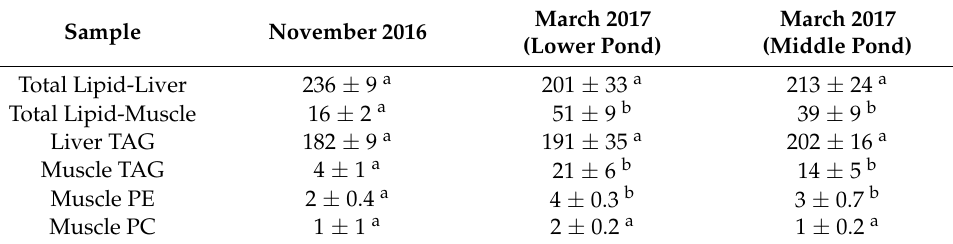
Table 2. Mean ( ± SD) total lipid and liver triacylglycerols (TAG), white muscle TAG, phos- phatidylethanolamine (PE), and phosphatidylcholine (PC) concentrations (mg g − 1 determined on a wet-weight basis) of young-of-the-year striped bass ( Morone saxatilis ) held in two freshwater ponds